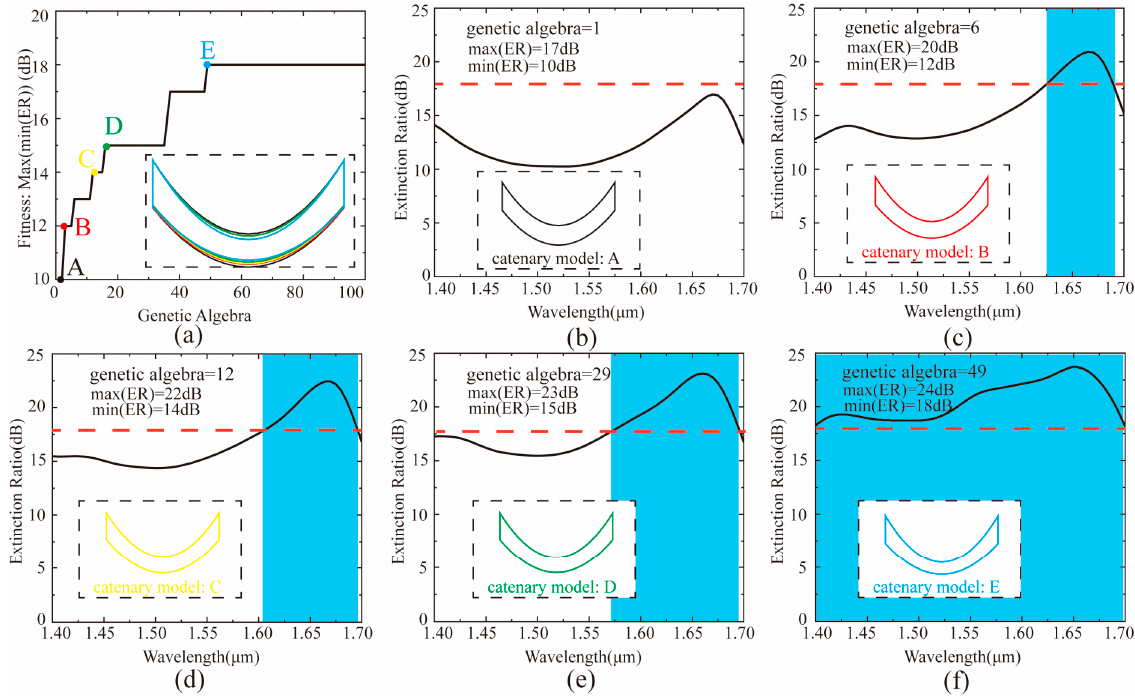
Figure 5. ( a ) The relationship between fitness (Max(min(ER))) function and genetic algebra. The illustration represents the optimal catenary structure at points A – E. ( b–f ) represent the relationship between the extinction ratio and the corresponding wavelength at points A – E in ( a ), respectively. The red dotted lines indicate that the extinction ratio is equal to 18 dB. The blue areas indicate the working bandwidth range when the extinction ratio is greater than 18 dB.